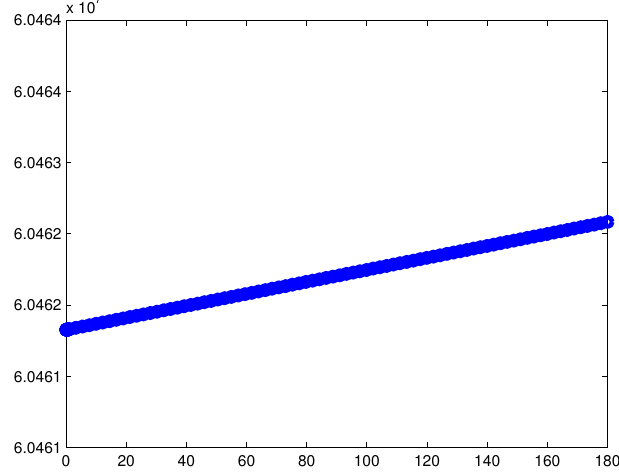
Figure 24. The susceptible population behavior over a year, without disease. It does not vary much as the vertical scale is rather small, the range of variation being around 3000, over a population of 60 × 10 6